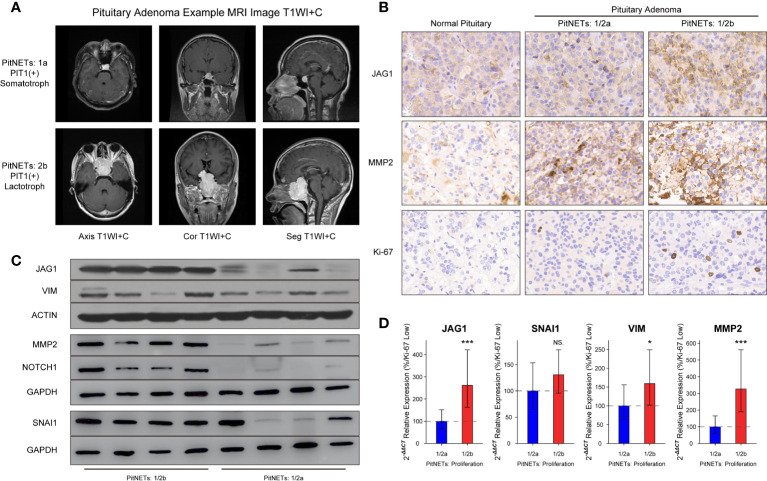
Levels of JAG1 and MMP2 in PA patients. (A) MR images of PA patients. (B) Bands of western blot on group 1/2a and group 1/2b. (C) Immunohistochemistry image of JAG1, MMP2 and Ki-67. (D) mRNA levels of JAG1, MMP2, SNAI1, and VIM. *compared to group 1/2a P<0.05 ***P<0.001. NS, no sense.